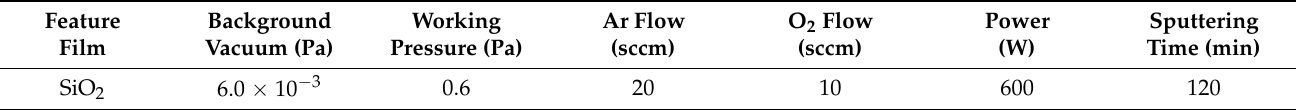
Table 3. Preparation process parameters of SiO 2 protective